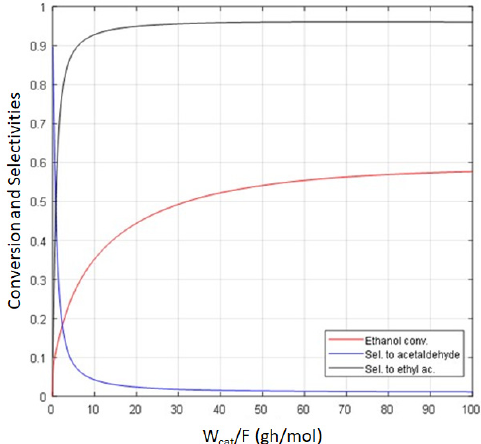
Figure 1. Kinetic behavior of copper-copper-chromite catalyst. Ethanol conversion and selectivities to respectively ethyl acetate and acetaldehyde, for different contact times at 493 K and 20 atm. Curves have been obtained by solving the system of differential Equations (10)–(13) with the parameters of Table 1.